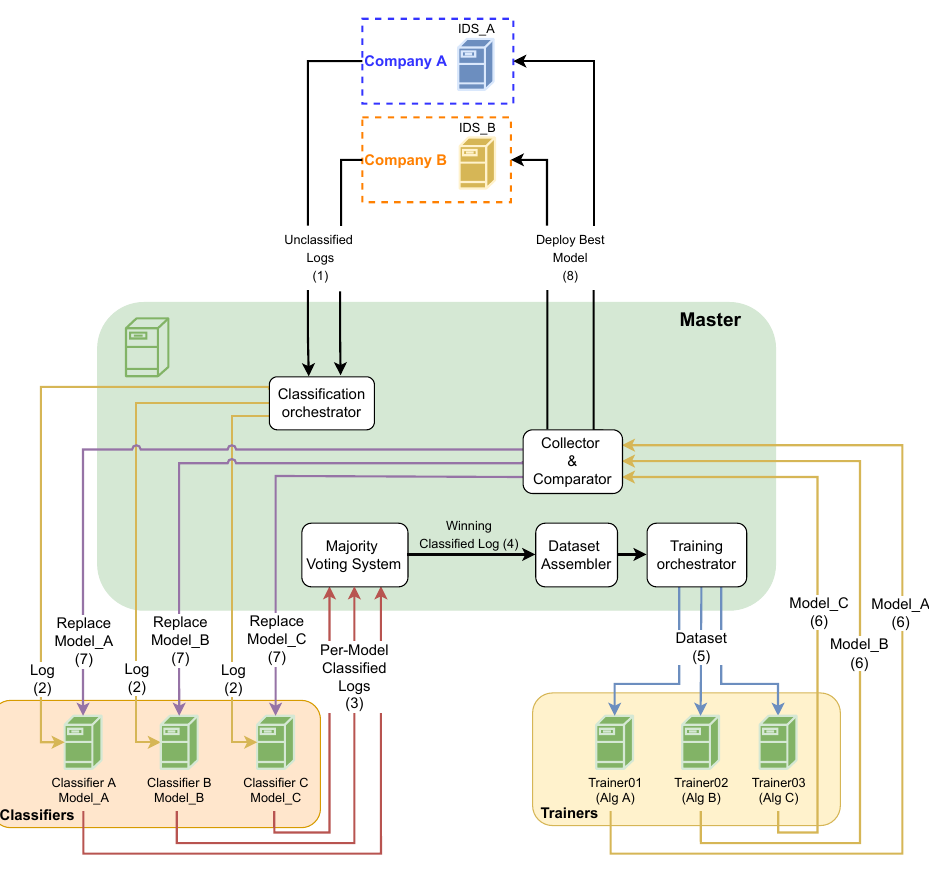
Figure 5. Master internal